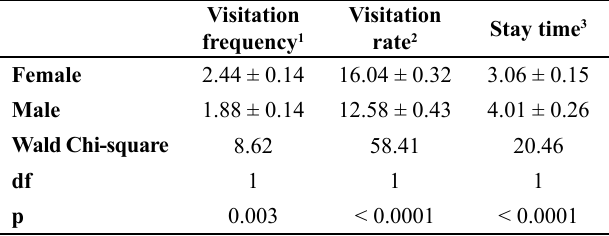
Table 1 . Results of Generalized Linear Mixed Model.